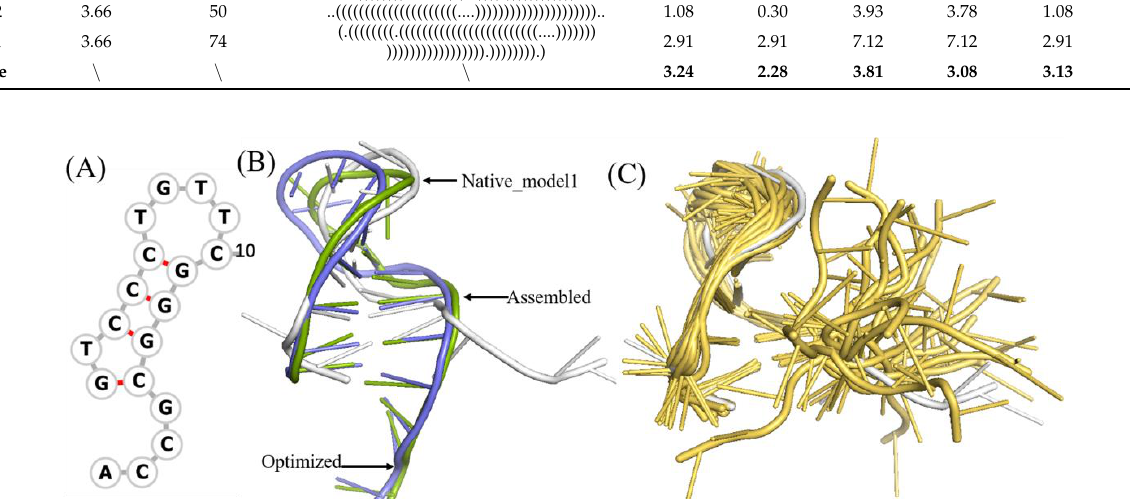
Figure 2. The structural analysis of open loop in a DNA (PDB ID 1EN1). ( A ) The secondary structure of 1EN1. ( B ) The native, assembled model and optimized structures are marked with grey, green, and blue, respectively. The first model in NMR selected as native. When the open loop is not considered, the RMSD of the assembled structure drops from 8.32Å to 4.2Å. ( C ) Twenty models obtained from the NMR experiment, of which model 1 is marked with grey. The 2D and 3D structures are generated by Forna [37] and PyMOL [38], respectively.